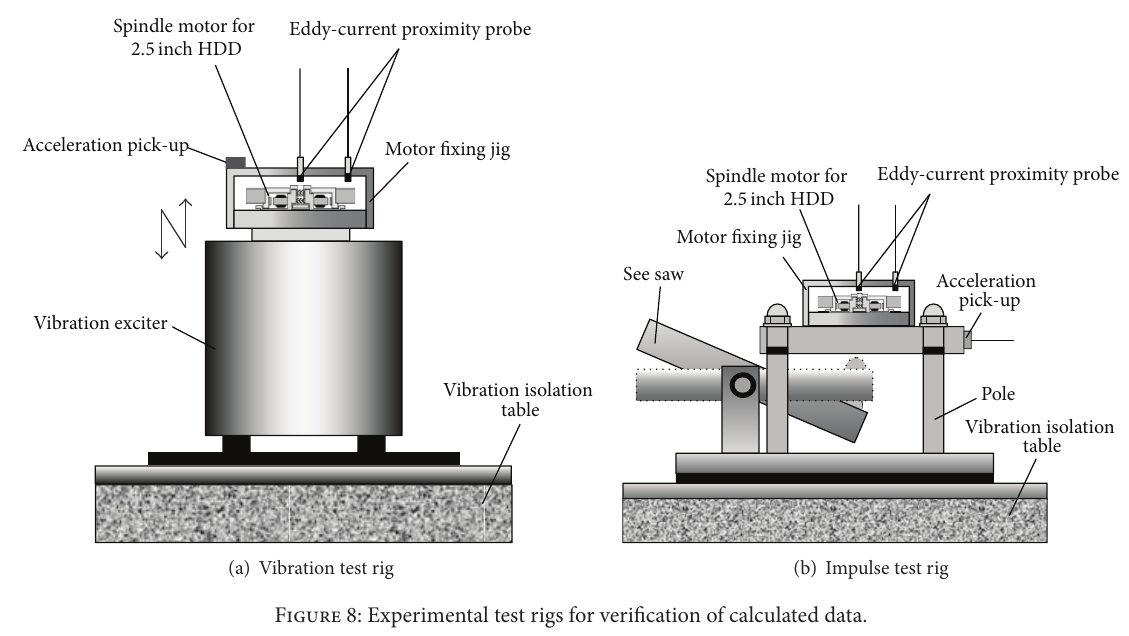
Figure 8: Experimental test rigs for verification of calculated data.